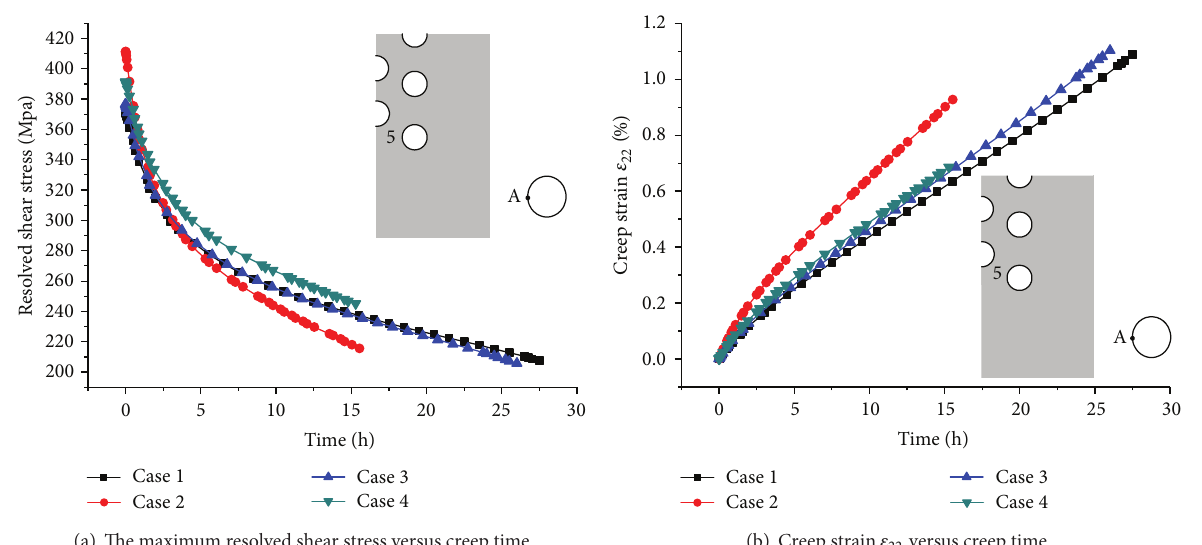
Figure 4: The comparison of creep characteristic for the four